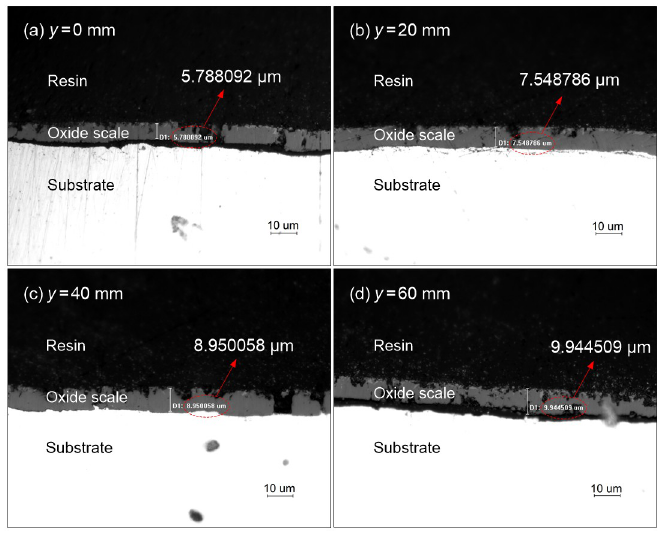
Fig 5. Cross-sectional microstructure of the oxide scale at different radial positions.